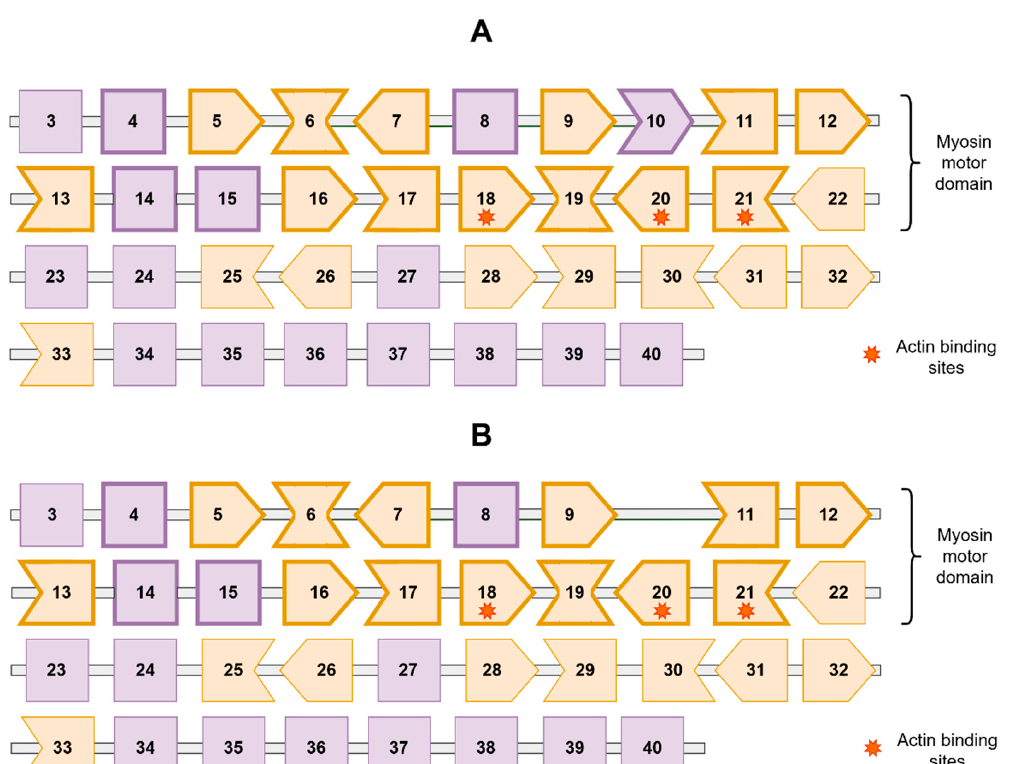
Figure 4. Schematic representation of exonic structure of the coding sequence of the MYH7 gene (transcript NM_000257.4) and its predicted splicing alteration. Each polygon with a number in its center denotes the corresponding exon (exons 1 and 2 are non-coding in NM_000257.4). The shape of an exon border indicates the reading frame. In-frame exons are coloured grey and the rest are coloured yellow. Exon boundaries overtaking (+1 or − 2) and lagging ( − 1 or +2) relative to the reading frame are shown as convex and concave, respectively. Polygons with bold contours represent the coding sequence of the myosin motor domain (exons 4-21). Orange stars indicate the sites of actin binding.